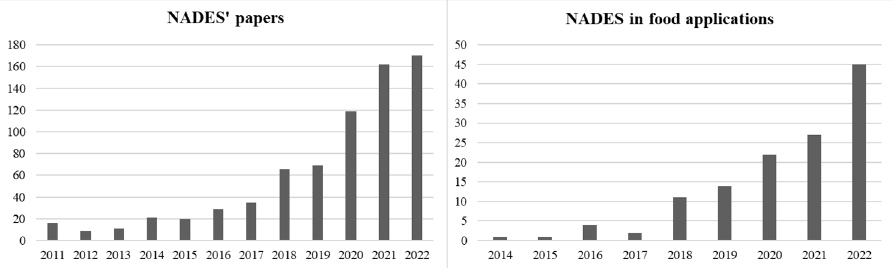
Figure 1. The number of papers published (source Scopus) since 2011 focusing on NADES (panel A) and NADES in food applications since 2014 (panel B). left) and NADES in food applications since 2014 (panel